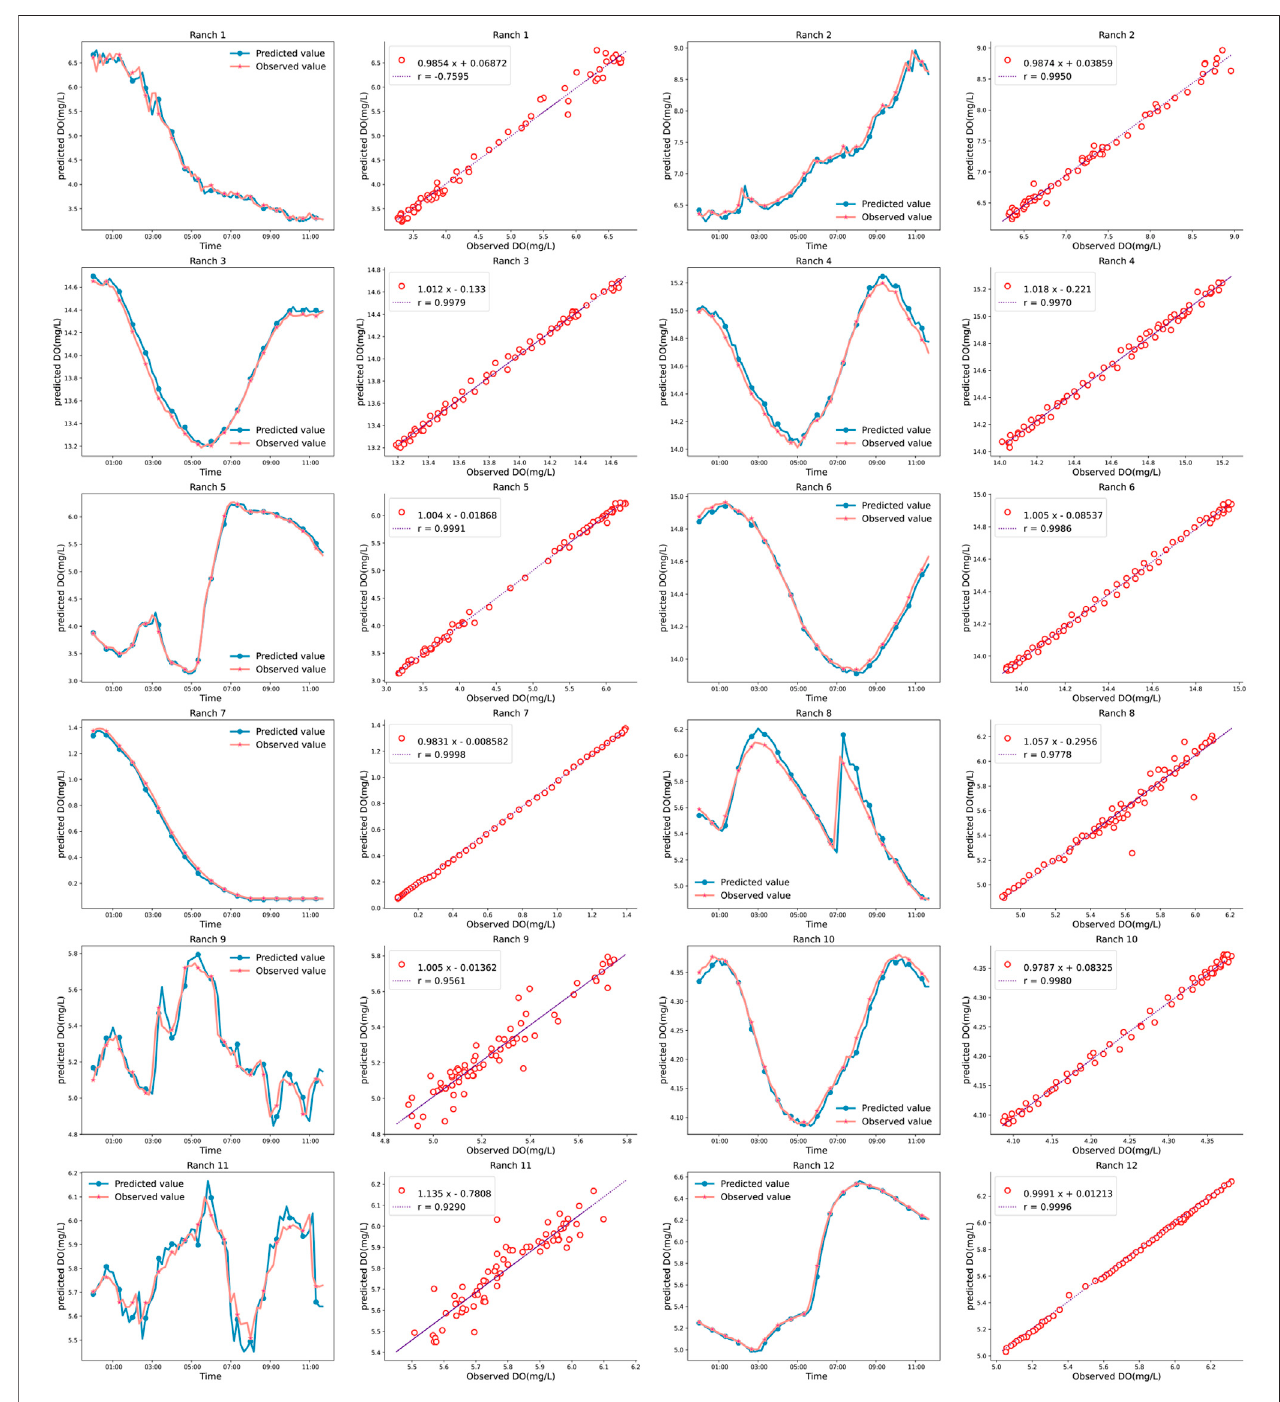
FIGURE 10 | Application of the model to data from different